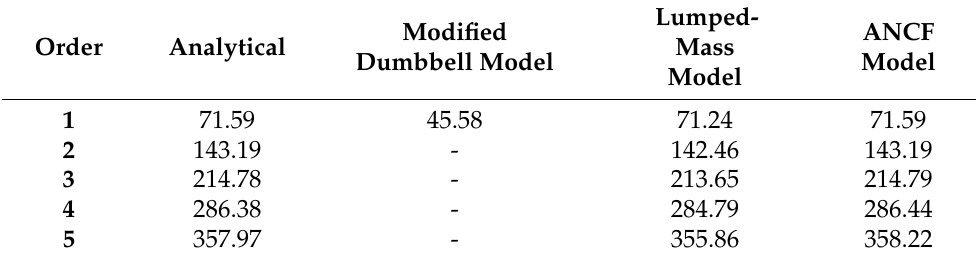
Table 4. Natural frequencies of the main tether (Hz).